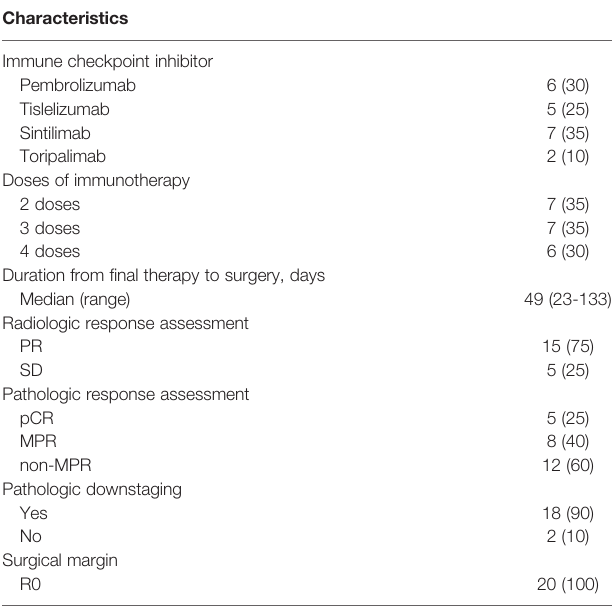
TABLE 2 | Neoadjuvant therapy characteristics.